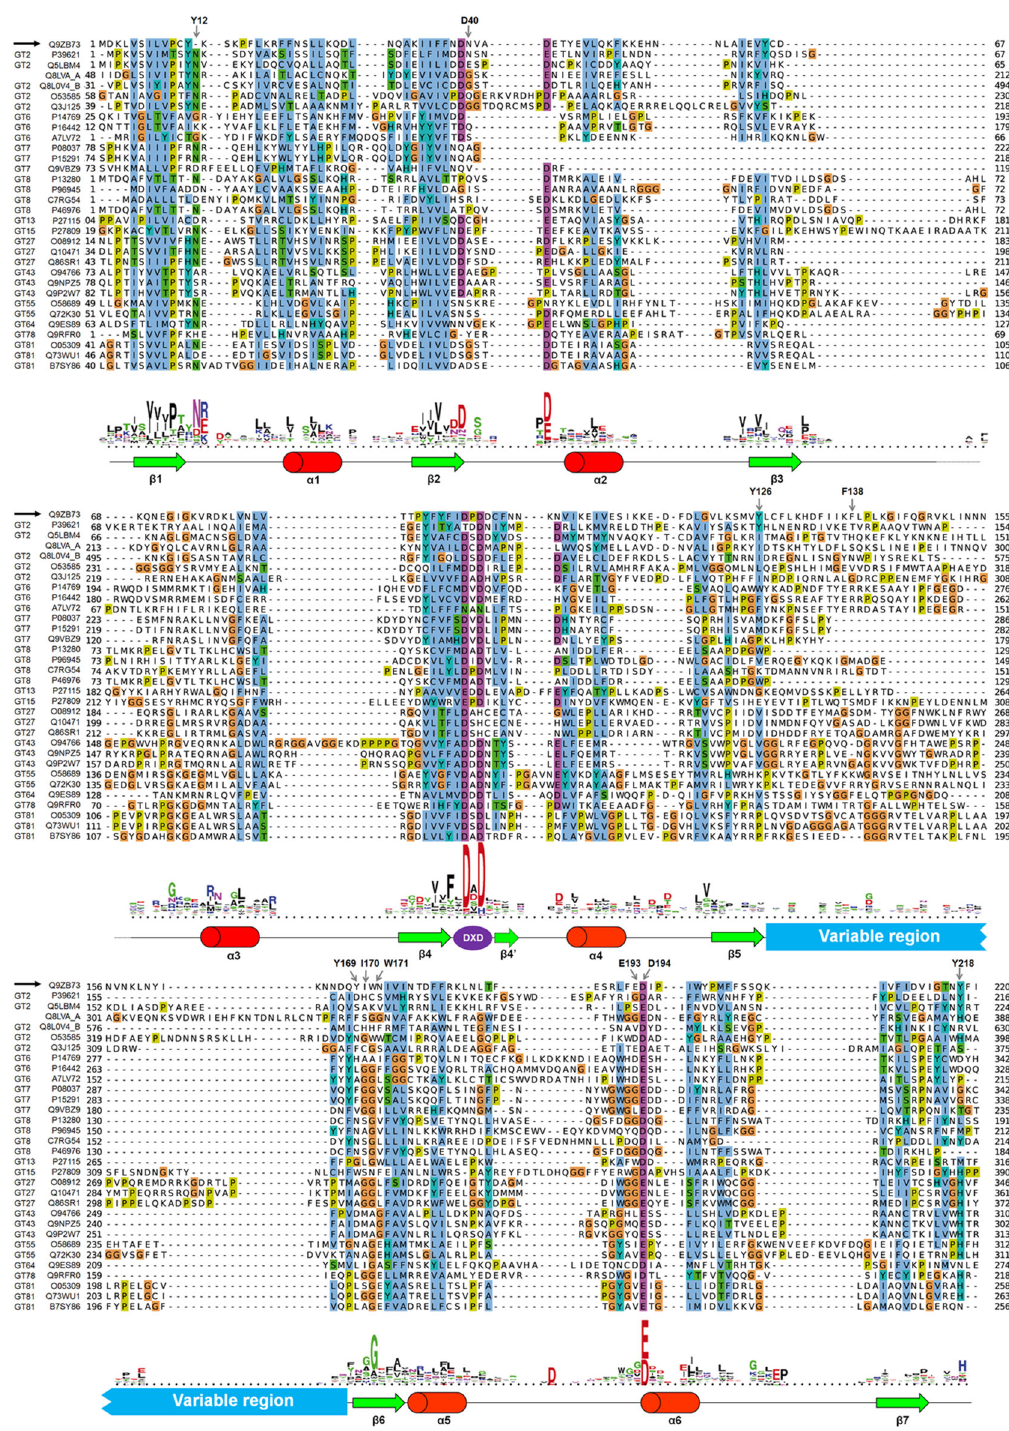
Figure 2. Sequence alignment of GT-A proteins with 3D structures solved by X-ray crystallography. Alignment logo, and consensus secondary structure are plotted below (full secondary structure alignment is detailed in Figure S1). MG517 sequence is aligned on the top (black arrow), and mutated residues are indicated by arrows.